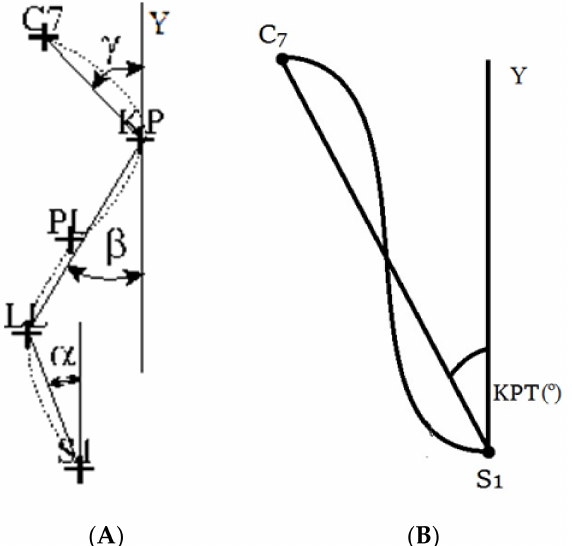
Figure 1. Angular parameters of the spine curvatures in the sagittal plane ( A ): the lumbosacral spine ( α -ALFA), the thoracolumbar spine ( β -BETA), the upper thoracic segment ( γ -GAMMA), and torso angle (KPT) ( B )